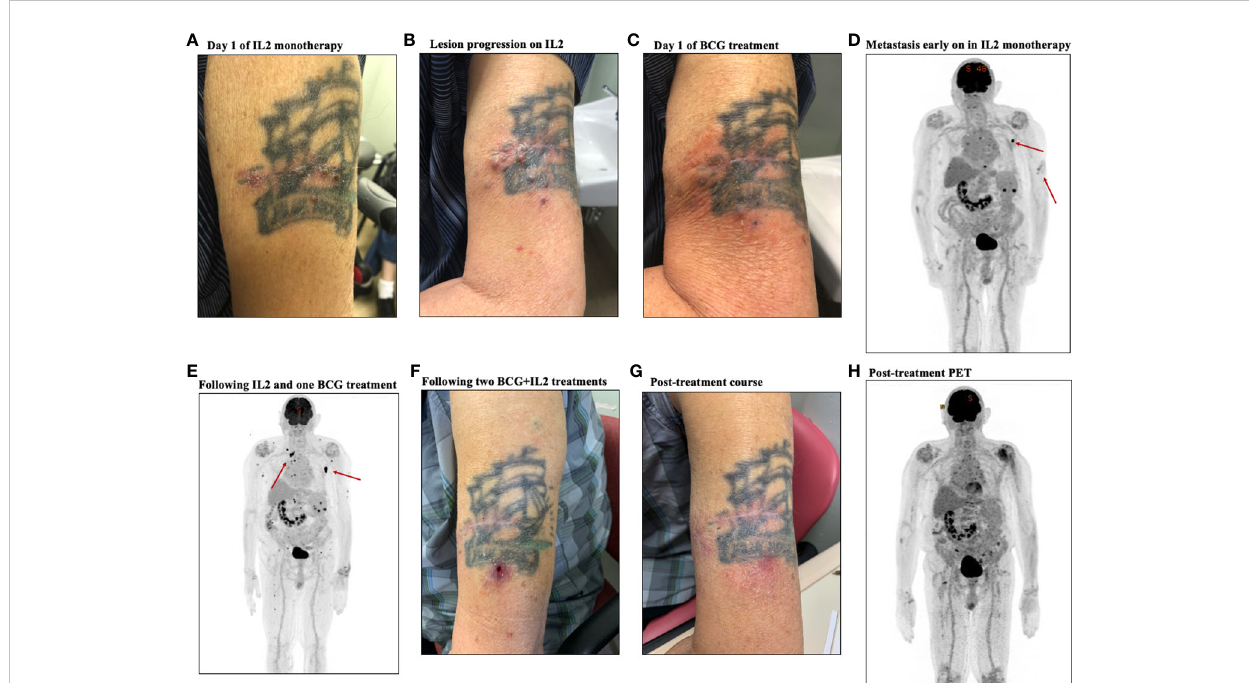
FIGURE 3 Representative clinical course of a case of a complete responder, patient #2. (A) Photo of primary lesion on day one of IL-2 treatment. (B) Photo of lesion following IL-2 monotherapy showing progression of lesions. (C) Photo of lesion on the day of BCG initiation, showing stable disease (D) PET- CT early on during IL-2 monotherapy showing extent of disease, with metastatic node highlighted. (E) PET-CT following treatment with IL-2 and one BCG treatment, showing metastasis. (F) Photo of the lesion following two BCG treatments, showing the typical ulceration seen with BCG injection. G. Photo of the treated area following treatment course, showing complete resolution. H. Post-treatment PET CT, showing reactive lymphadenopathy with no further evidence of metastatic disease and radiographic resolution of the cutaneous